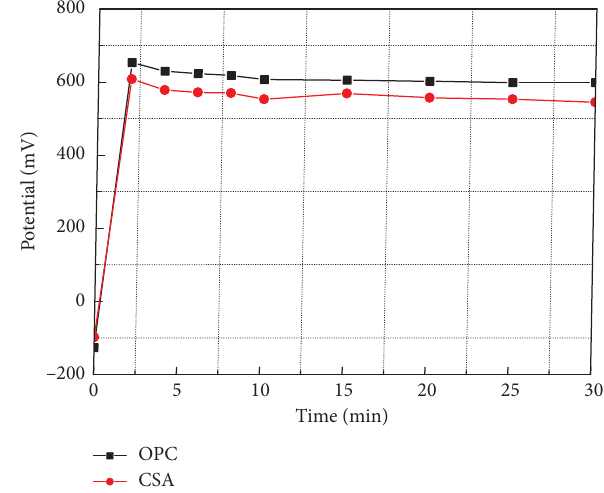
Figure 3: Polarization potential-time curves of steel reinforced CSA and OPC